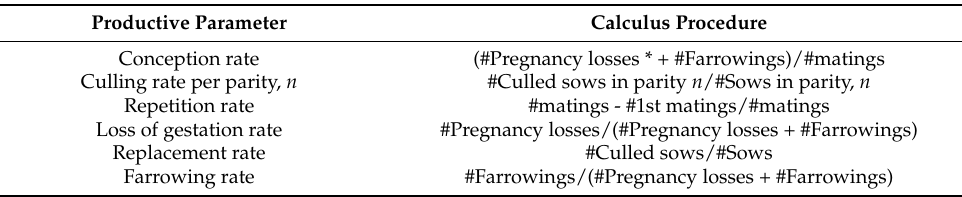
Table 6. Definition of the procedure to calculate several rates either as input parameters (calculation from farm data records) or output parameters (calculation from simulated